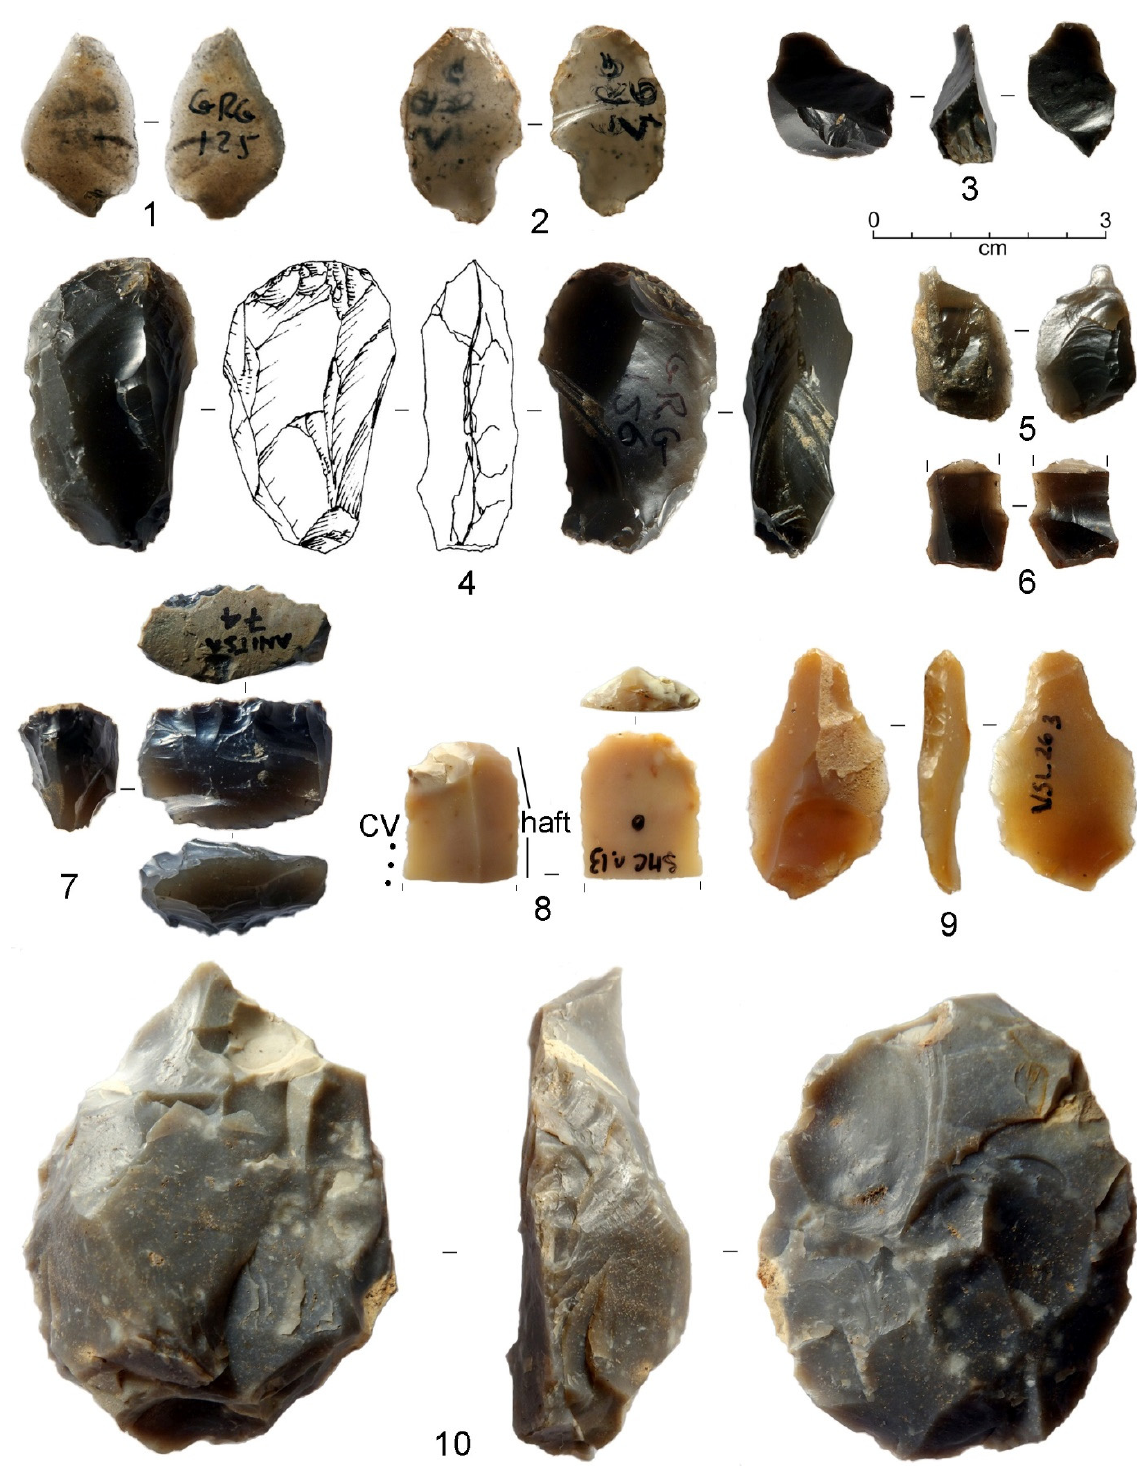
Figure 6. Non-local artefacts made from Vikos “black chert” from different sites: GRG-125 (n. 1), GRG-46 (n. 2), GRG-121 (n. 3), GRG-156 (n. 4), GRG-39 (n. 5), GRG-144 (n. 6), Anitsa-74 (n. 7: microbladelet core), and VSL-305 (n. 10: microflakelet core or preform of a bifacial point), and blonde non-local chert SMC-13 (n. 8: hafted, long-end scraper used for cutting vegetation (CV), VSL-263 (n. 9: straight perforator heavily worn and broken) (photographs by E. Starnini).